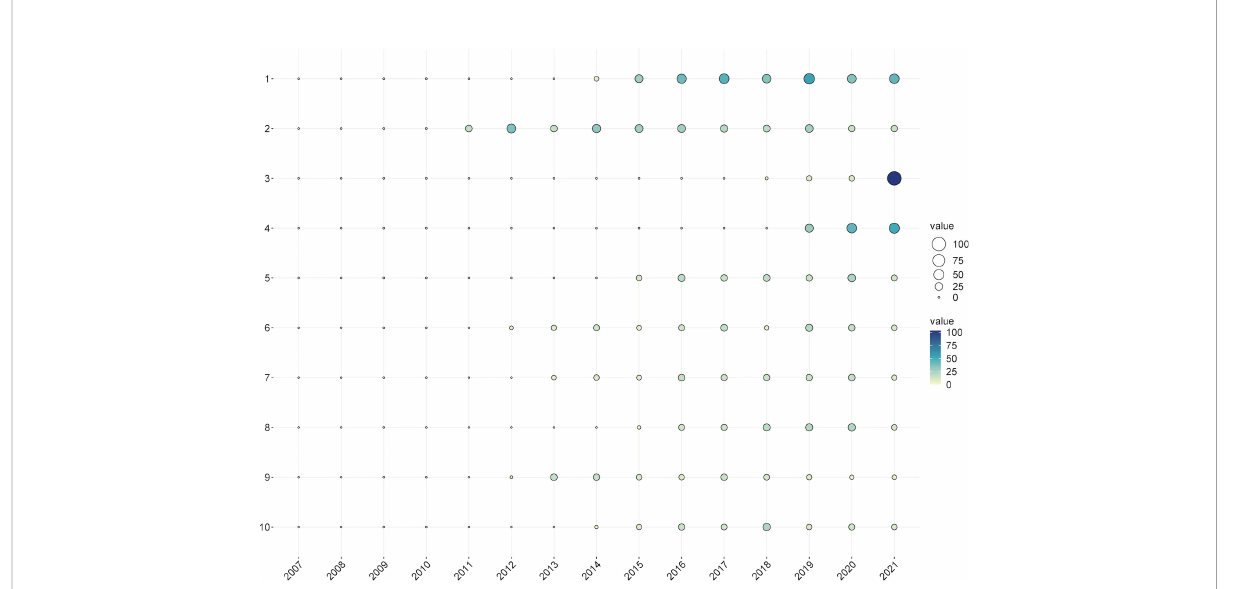
FIGURE 4 The yearly number of local citations of papers with high local citations (LCS). (The size and colors of the circle represent the LCS of